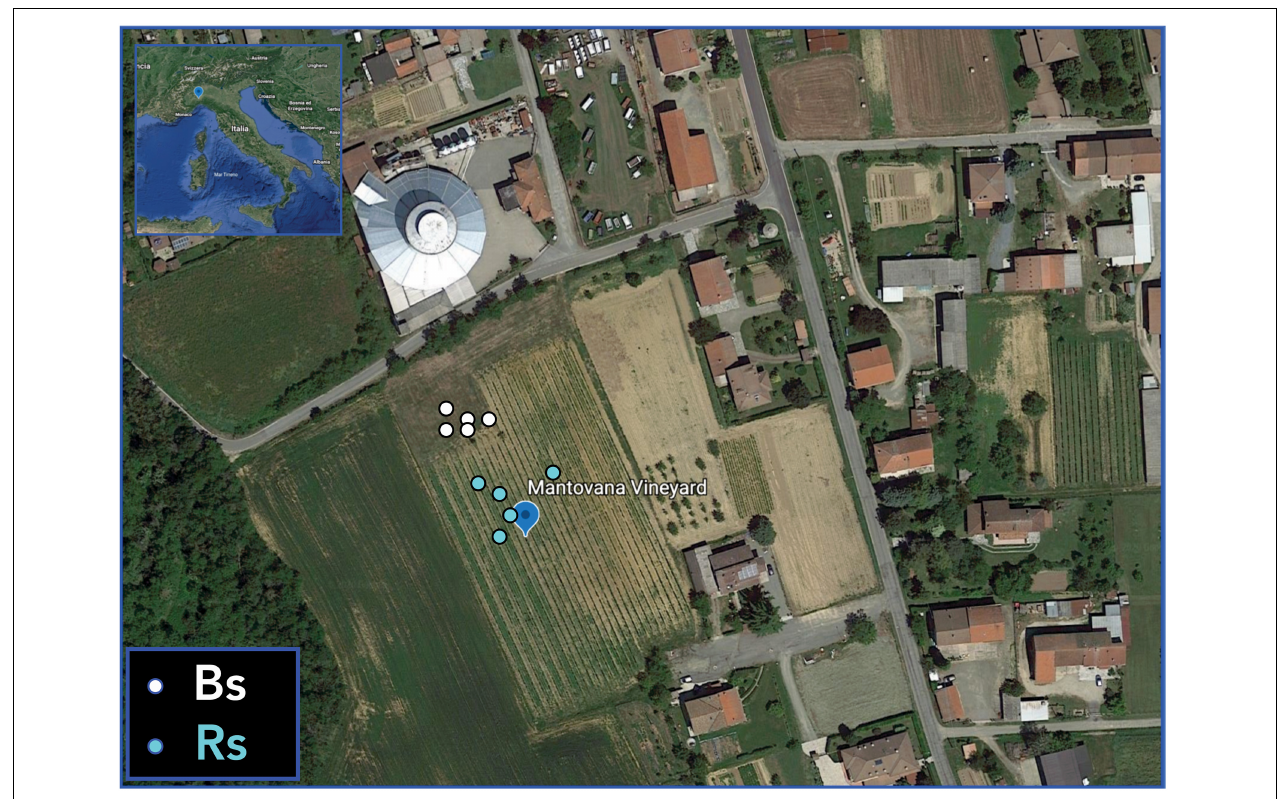
FIGURE 1 | Vineyard aerial view showing the sampling points. The vineyard is located in Mantovana (Predosa municipality, Alessandria, Italy). The two soil sampling sites included one in an area just outside the borders of the vineyard in the absence of grapevines (Bs, white dots) and one inside the vineyard corresponding to the grapevine plants (Rs, cyan dots). Google Earth online version was used to produce this image (https://earth.google.com/web/).